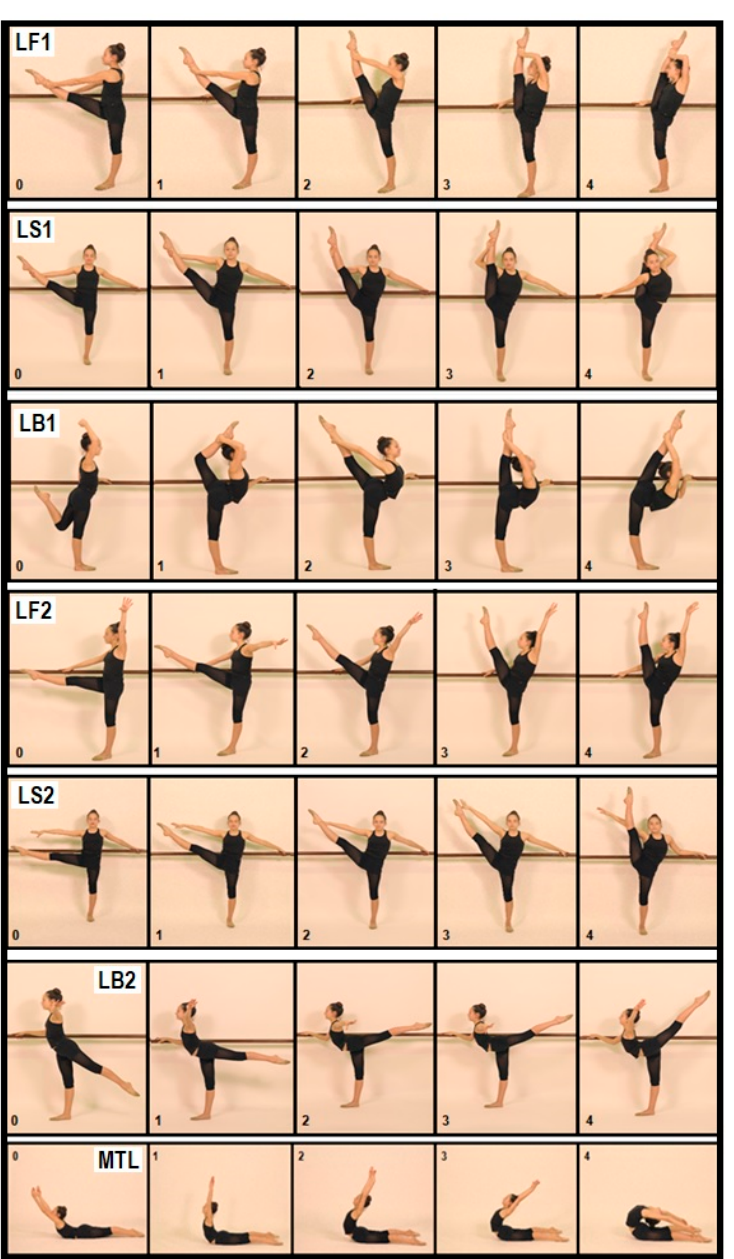
Figure 1. Reference points (0–4) of flexibility tests—Leg pull forward with help of the hand (LF1); sideways (LS1) or backward (LB1); leg raise forward (LF2), sideways (LS2) or backward—arabesque (LB2); maximum trunk lift (MTL).